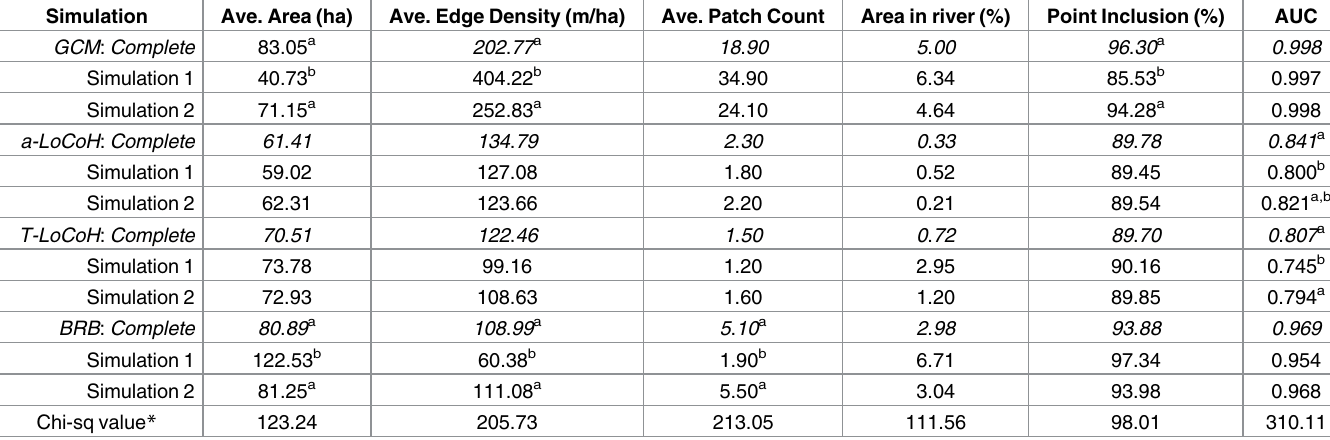
Table 2. Summaryof simulation home range